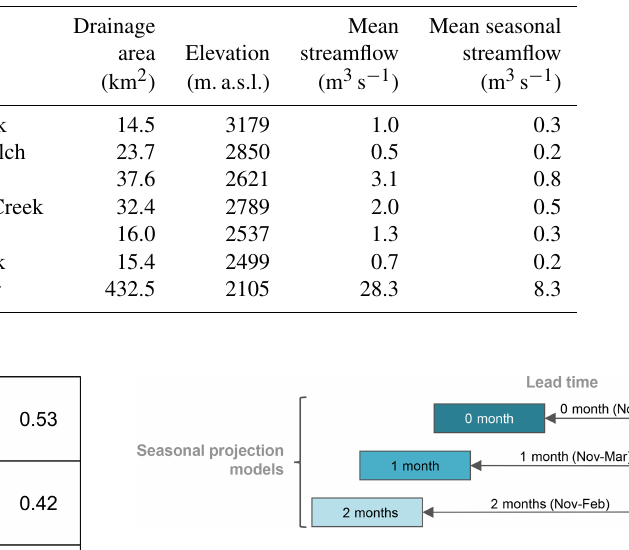
Figure 4. Schemes of nonstationary models considered for three different lead times. The dark turquoise box denotes the model for a 0-month lead time (projections are released on 1 May), the turquoise box the model for a 1-month lead time (projections are released on 1 April), and the light turquoise box the model for a 2-month lead time (projections are released on 1 March). The same color scheme will be considered for the Sect.